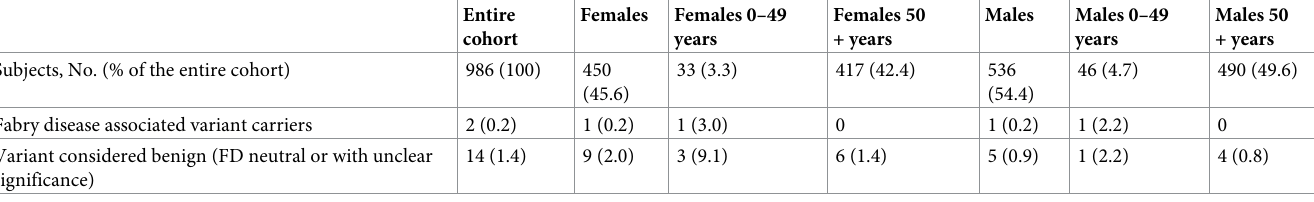
Table 3. Frequency of variant GLA genotype in study population stratified by sex and